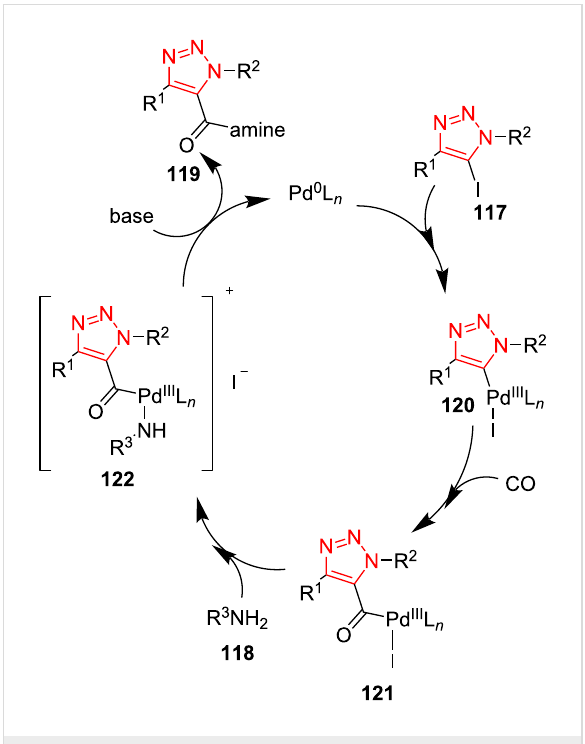
Scheme 36: A probable mechanism for the synthesis of 1,4,5-trisubsti- tuted 1,2,3-triazole-5-carboxamides 119